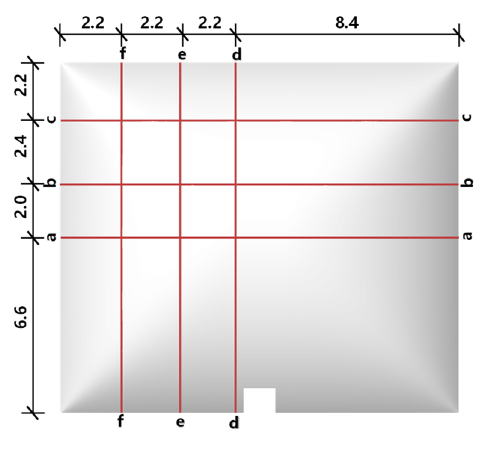
Figure 24. Sectional position.